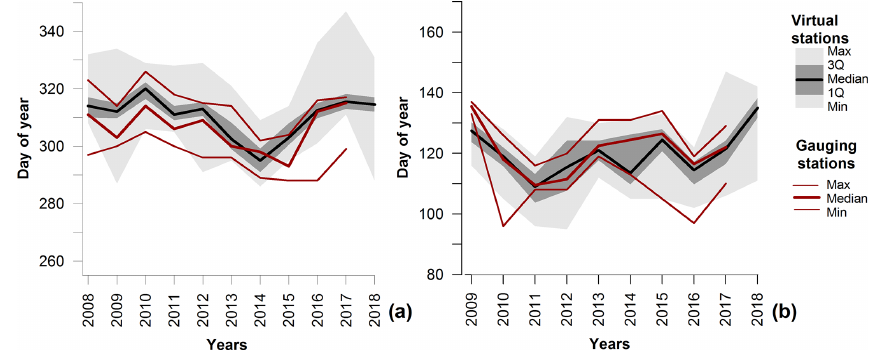
Figure 8. Interannual variability of dates of (a) ice onset and (b) melt start for the main Ob River channel retrieved using the manual routine. The statistics are estimated using data from 4 gauging stations and 20 virtual stations located along the main Ob River channel. Table 2. Coefficients a and b for the built relations, correlation coefficient ( R ) and RMSE between the retrieved and in situ ice thickness for virtual stations from the training set. SOb refers to virtual stations located on the secondary (western) river branch of the Ob (see Fig. 1). Coefficients of Eq. (1) Validation scores Virtual Corresponding Distance to a gauging